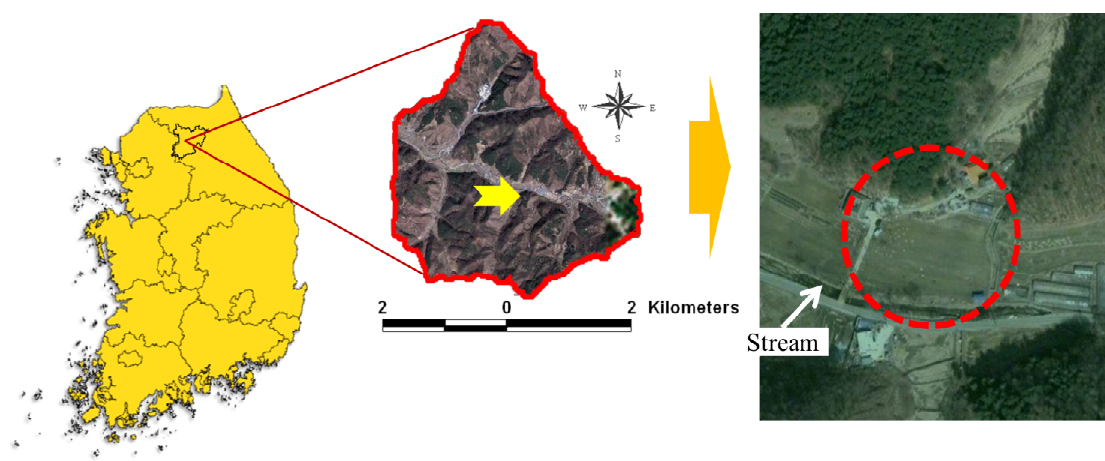
Figure 10. Location of Su-dong study watershed in South